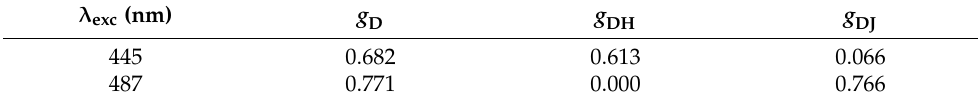
Table 3. The contributions of dimers g D , g DH , and g DJ to the total absorption of the sample. λ exc (nm)